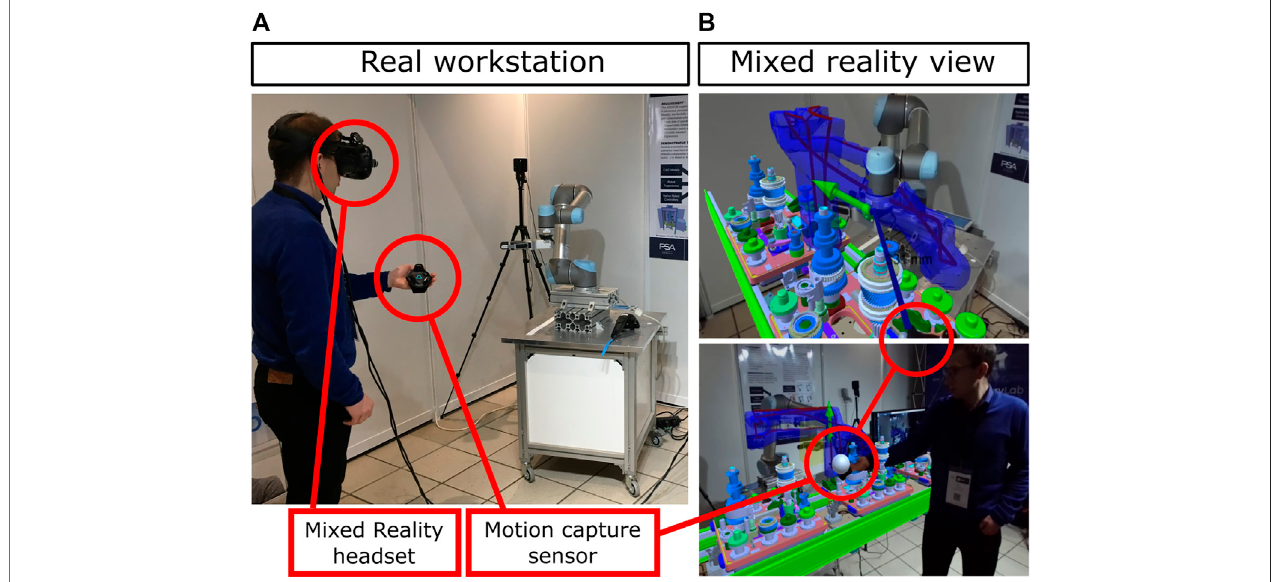
FIGURE 11 | An industrial use case involving one UR5 robot. The real workstation (A) is augmented with a virtual 3D environment and safety criteria (B) : robot sweptvolume and velocity, minimum distance withthe user.The userisimmersed inside thedigital twinthanks toamixedreality headset(HTC Vive+Zed mini camera).